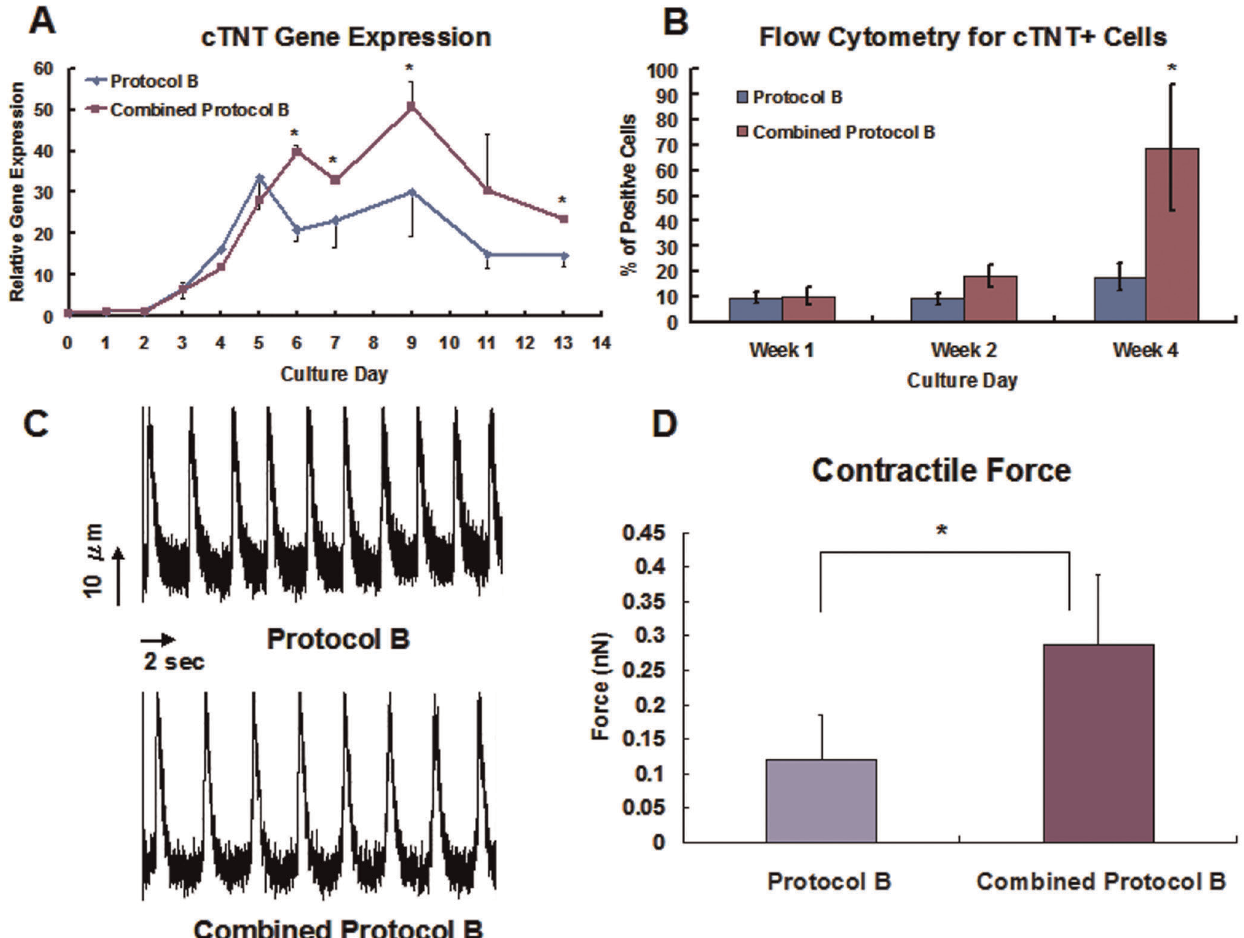
Figure 6. Synergistic effects of apelin on hESC in serum-reduced Combined Protocol B. (A) Significant up-regulation of cTNT gene expression is seen in Combined Protocol B, (B) Significant increase of cTNT + cells is observed in Combined Protocol B, (C) No significant difference in Ca 2 + transient is seen in the hESC-derived cardiac cells between Combined Protocol B and control groups, and (D) Significant increase in peak contractile force was observed in Combined Protocol B vs. Protocol B (*p , 0.05).